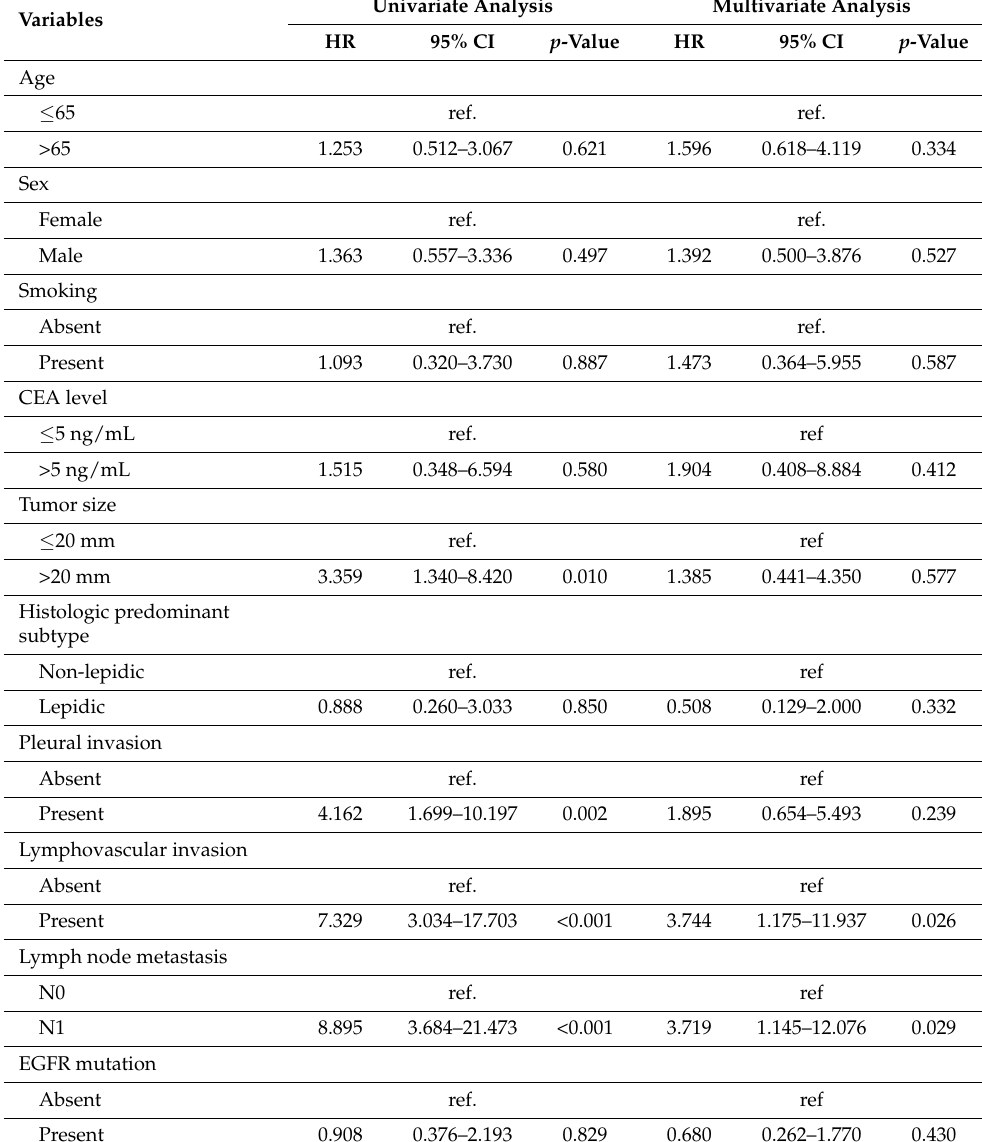
Table 4. Univariate and multivariate analysis of overall survival probabilities after